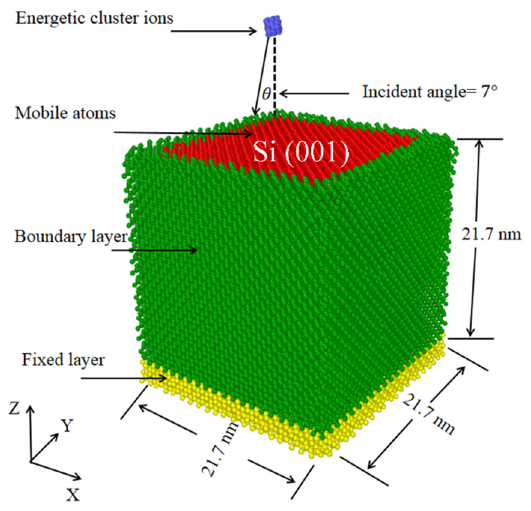
Figure 1. The three-dimensional molecular dynamics (MD) model for energetic cluster ion implantation into a monocrystalline silicon target.